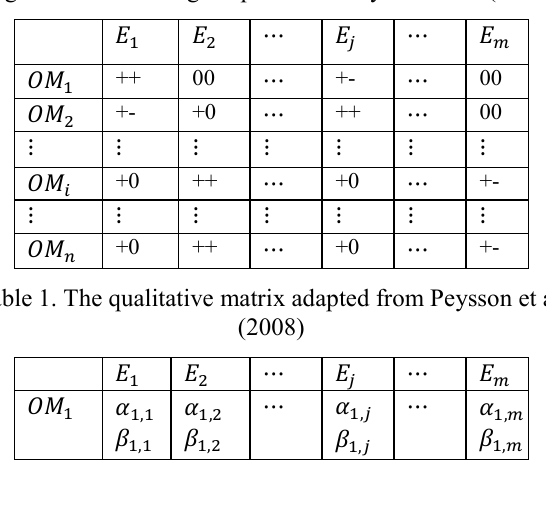
Figure 2. Qualitative and Quantitative descriptions of degradation modeling adapted from Peysson et al. (2008).